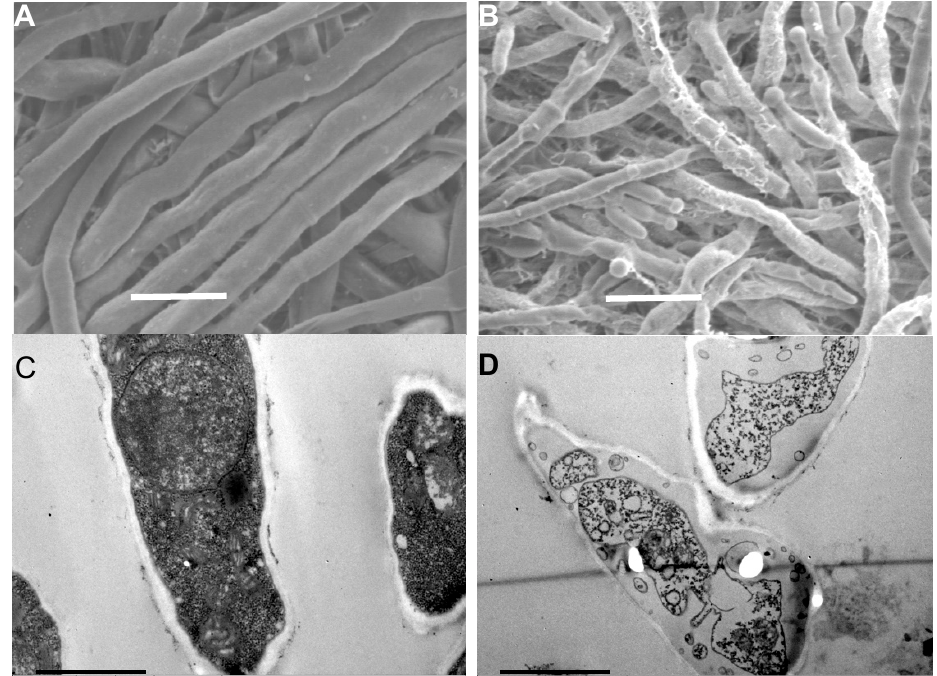
Figure 3. Effects of PiCB on hypha morphology and cell ultrastructure. ( A ) P. digitatum mycelia (Control); ( B ) P. digitatum mycelia treated with PiCB (100 mg/L). Images observed using scanning electron microscope (SEM) (2500×). Bar scale = 10 μ m. ( C ) P. digitatum cells (Control); ( D ) P. digitatum cells treated with PiCB (100 mg/L). Images observed using TEM (20,000×). Bar scale = 1 μ m.